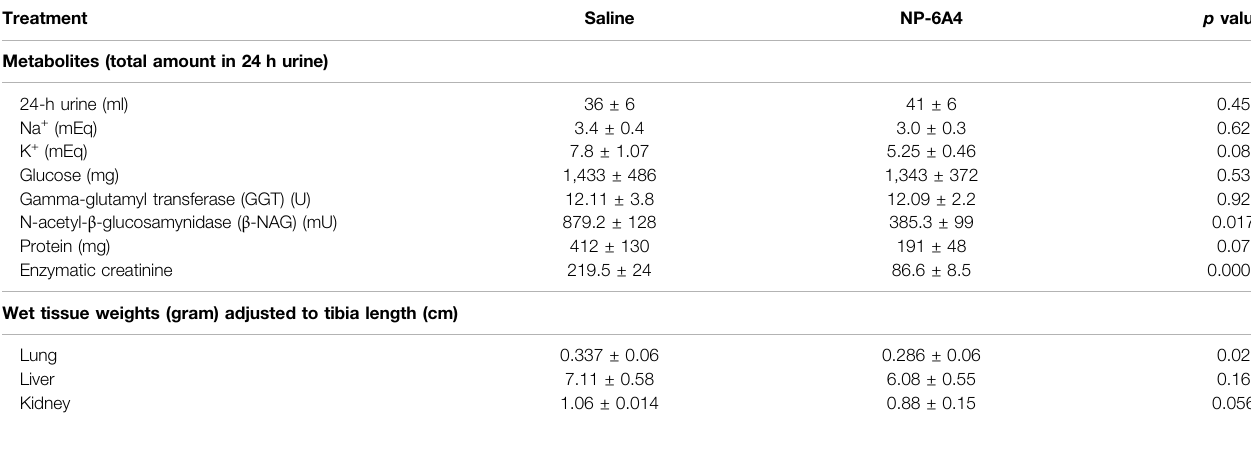
TABLE2| EffectsofNP-6A4treatmentonurineparametersandwetweightsofothertissuesthanheartinZuckerobeseratswithuntreateddiabetes,obesity,andmetabolic syndrome.